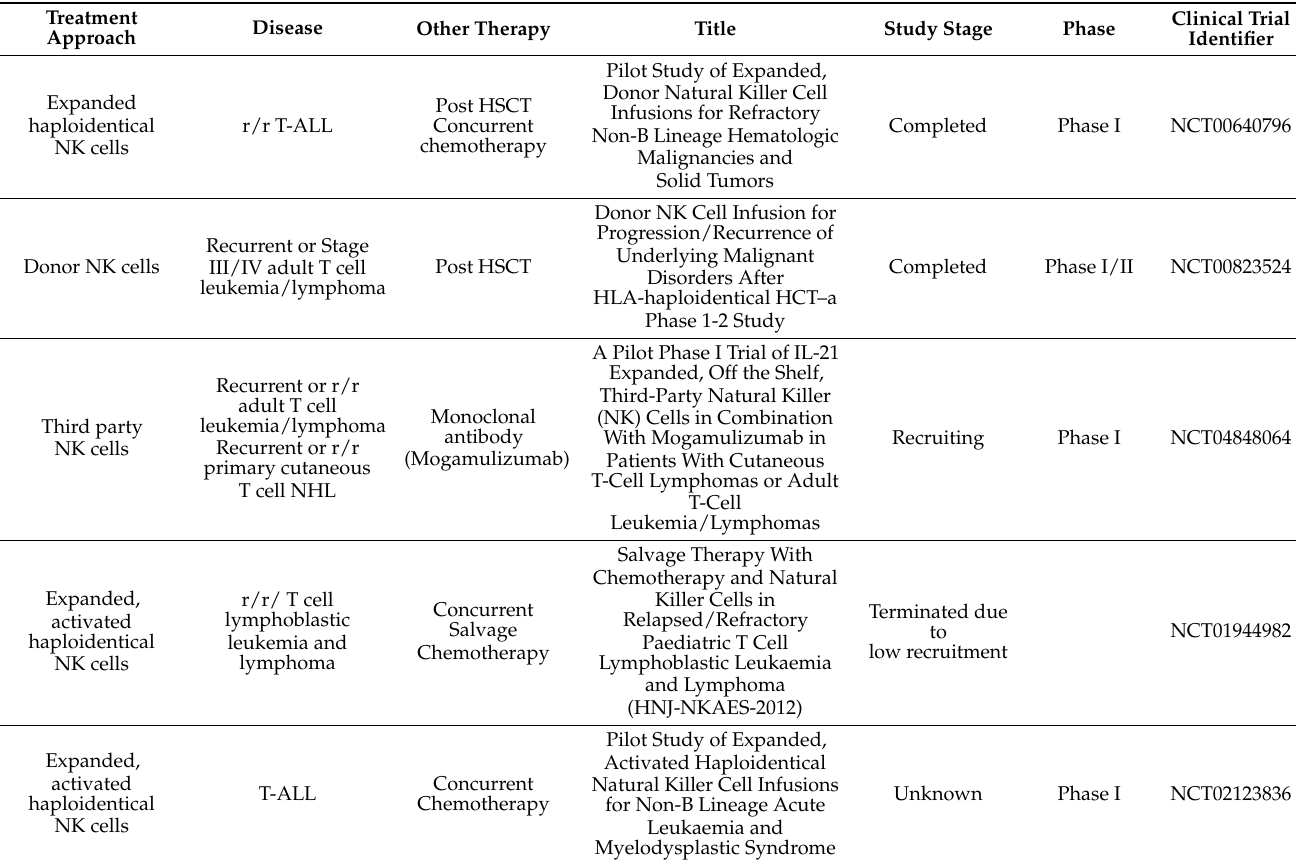
Table 5. Clinical trials of NK cell therapy for T-cell